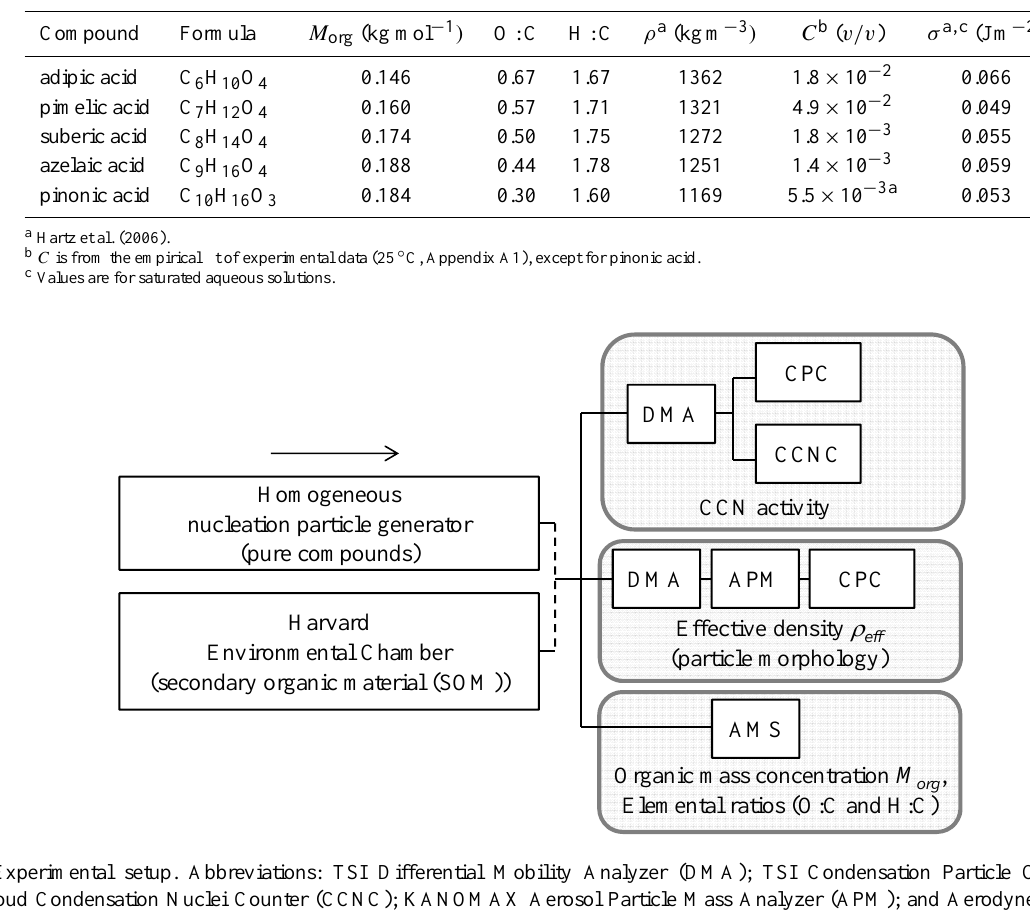
Table 1. Properties of tested organic compounds.